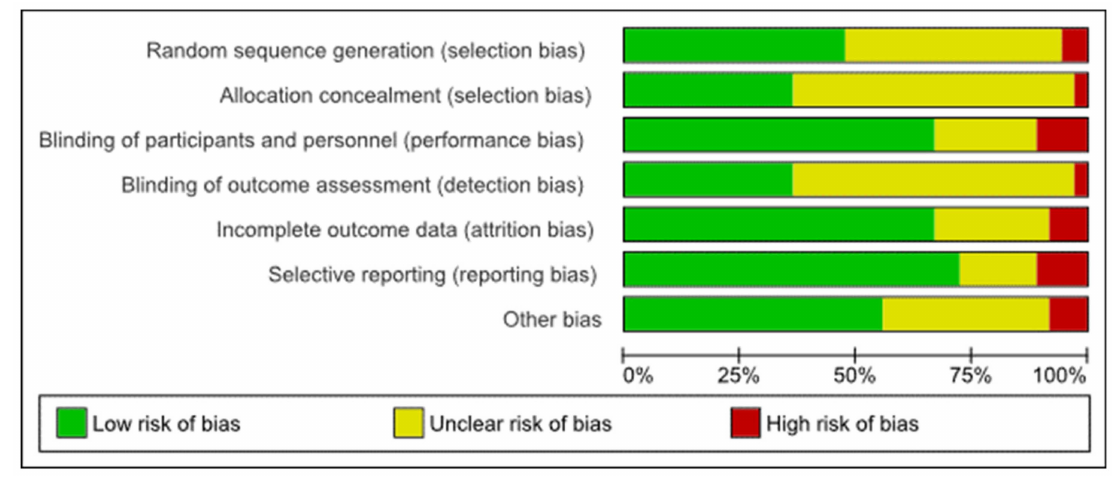
Figure 2. Risk of bias graph.